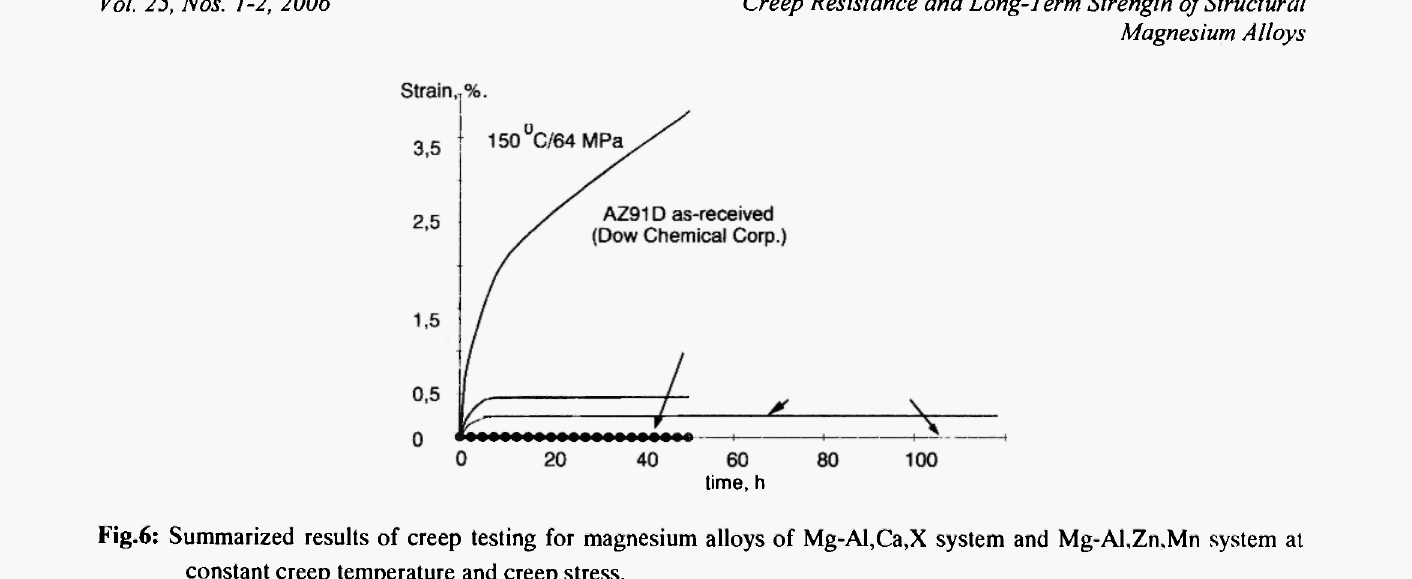
Creep resistance of die cast the RE-free magnesium